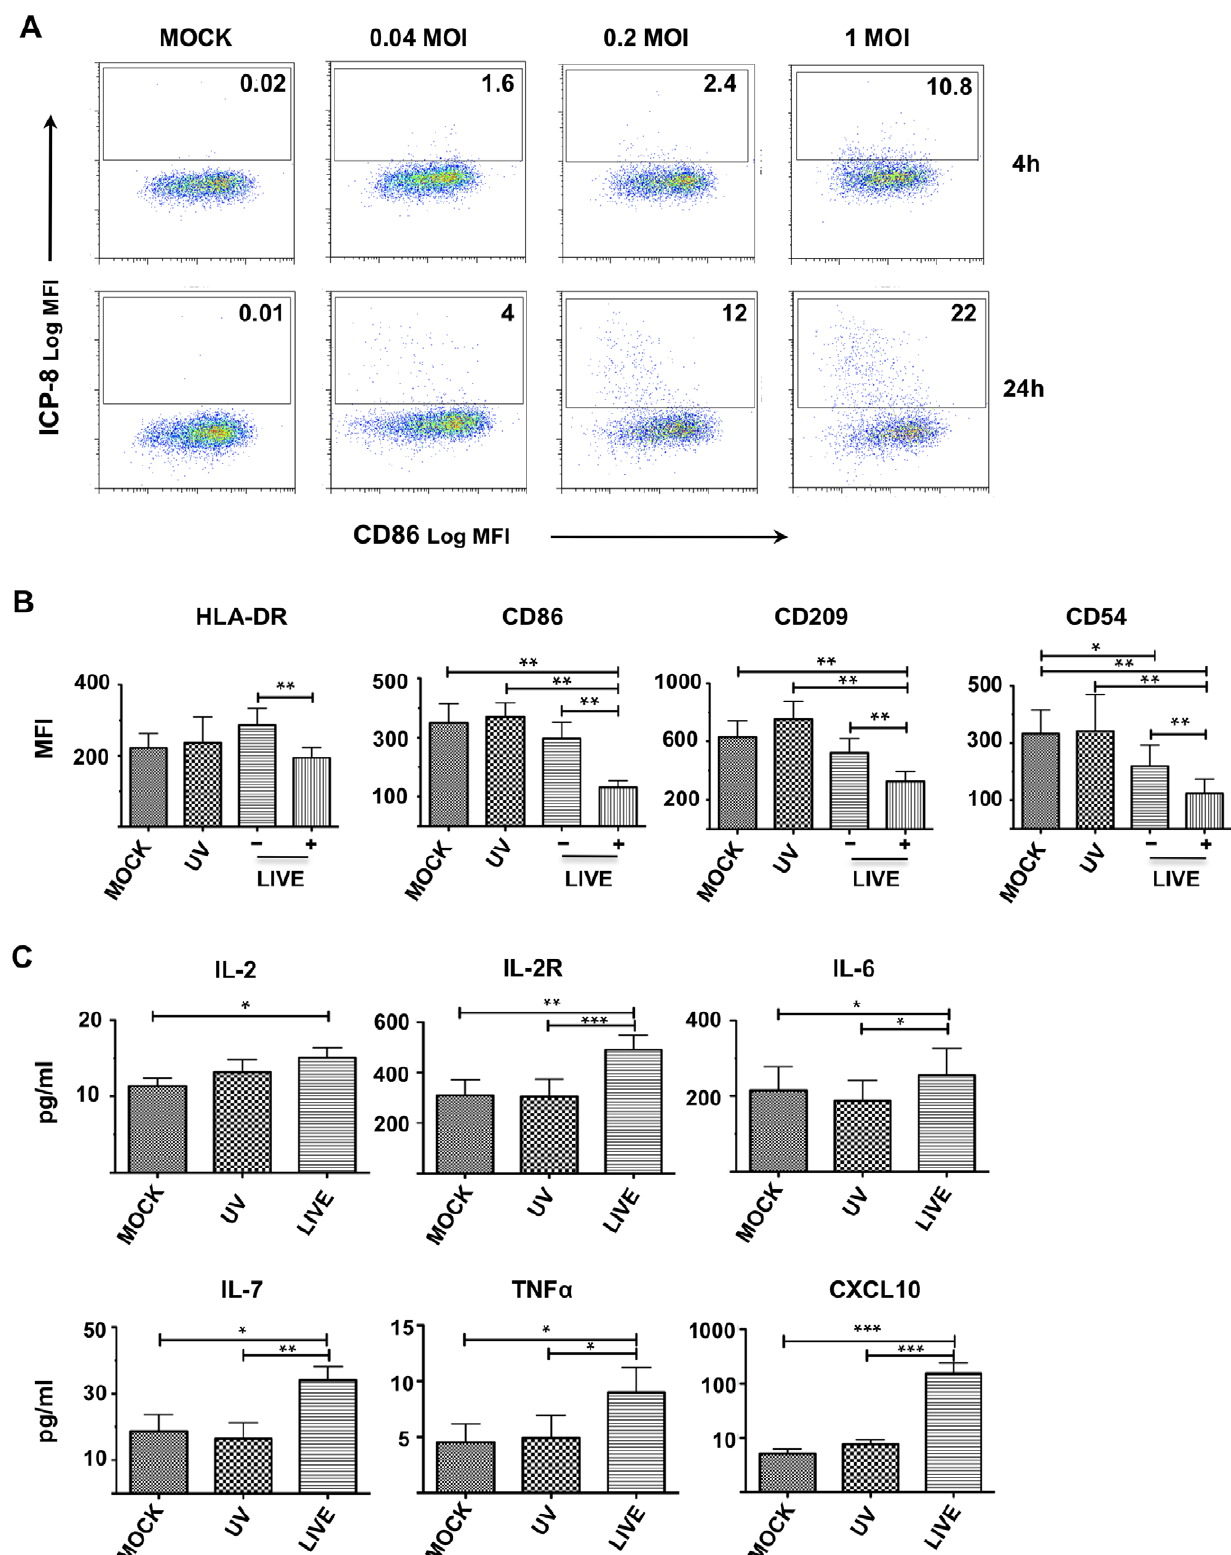
Figure 3. Low level HSV-2 infection modulates DC function. A) Immature moDCs were exposed to 0.04, 0.2, or 1 MOI of replication competent HSV-2 (or medium, MOCK) and infection was monitored by measuring the expression of ICP-8 at 4 h and 24 h. The percentage of ICP-8 + (infected) cells is indicated in each panel. One representative experiment of 5 is shown. B) DCs were treated with 0.2 MOI of replication competent (LIVE) or UV- HSV-2 (UV) versus mock (MOCK) supernatant and the surface phenotype assessed after 24 h. The mean fluorescent intensities (MFI) (means 6 SEM, 5